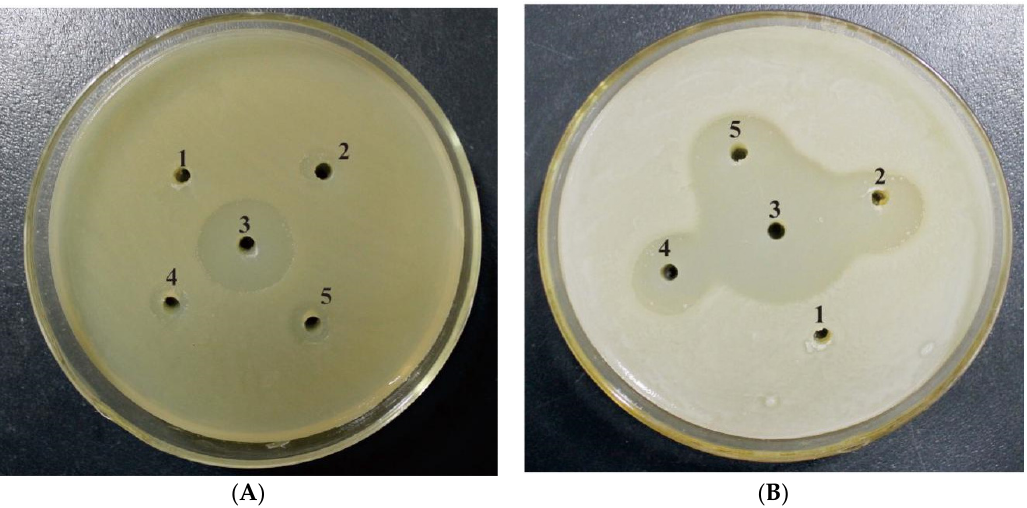
Figure 5. Antibacterial activity analysis of combinational mNKLs against Staphylococcus aureus ( A strain ATCC 25923) and E. coli ( B strain DH5 α ). 1 was sterile ddH 2 O; 2 , 4 , 5 were recombinant mNKL1, mNKL2 and mNKL3 (5 µ g/well), respectively; 3 was ampicillin (10 µ